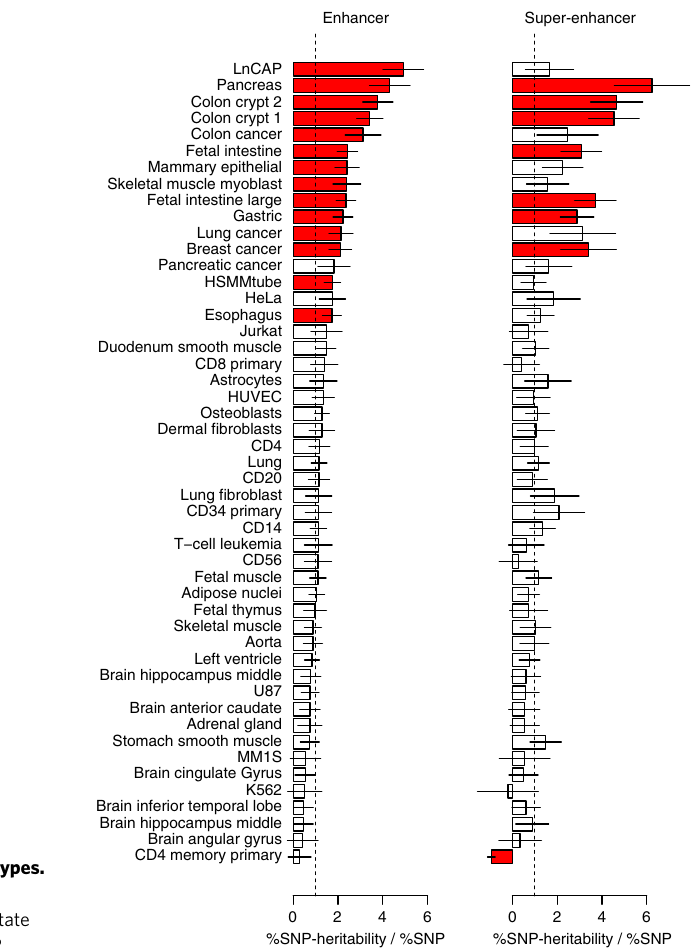
Figure 4 | Comparison of enhancers and super enhancers across 49 cell types. Each bar represents the %SNP heritability %h 2 enhancers (left) and super enhancers (right) from a given cell type tested marginally. Red indicates significant difference from 1.0 (no enrichment) after accounting for 49 tests. Enhancer LNCAP is most significant, with other cancers also appearing significant and non-cancer tissues least significant. Error bars show analytical s.e. of